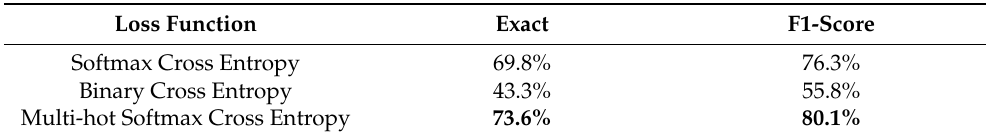
Table 2. Results for KorQuAD v1.0 regarding the loss function; list of tokens based on BPE and syllables, tested with a small